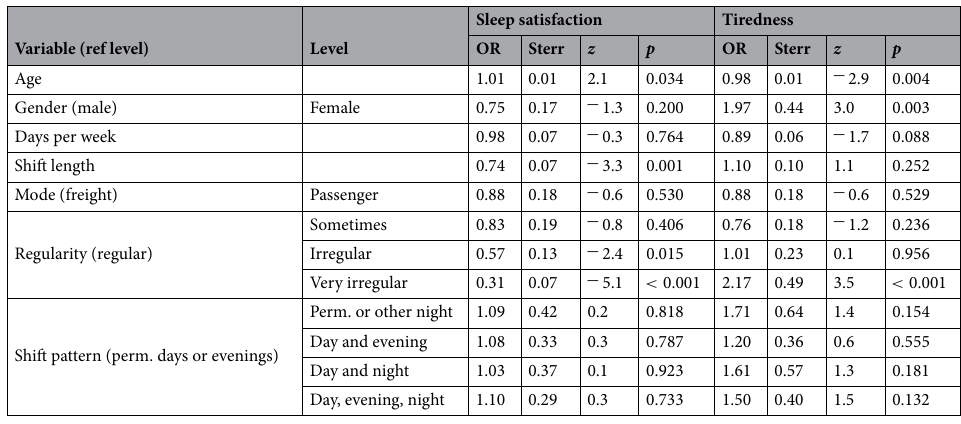
Table 2. Ordinal regression for perception of sleep satisfaction (1 = nowhere near enough) and tiredness (1 = almost never) controlling for age, gender, and number of days per week worked. Post-hocs for regularity (regular = 1, somewhat = 2, irregular = 3, very irregular = 4)—sleep satisfaction (1 > 2 > 3 > 4), tiredness (1, 2, 3 < 4); perm. permanent.